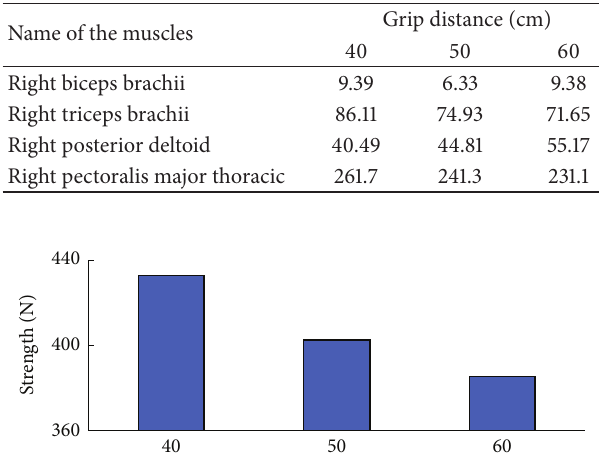
Table 3: The major muscles using varying grip widths with identical forces of 25 kg (unit: 𝑁 ).